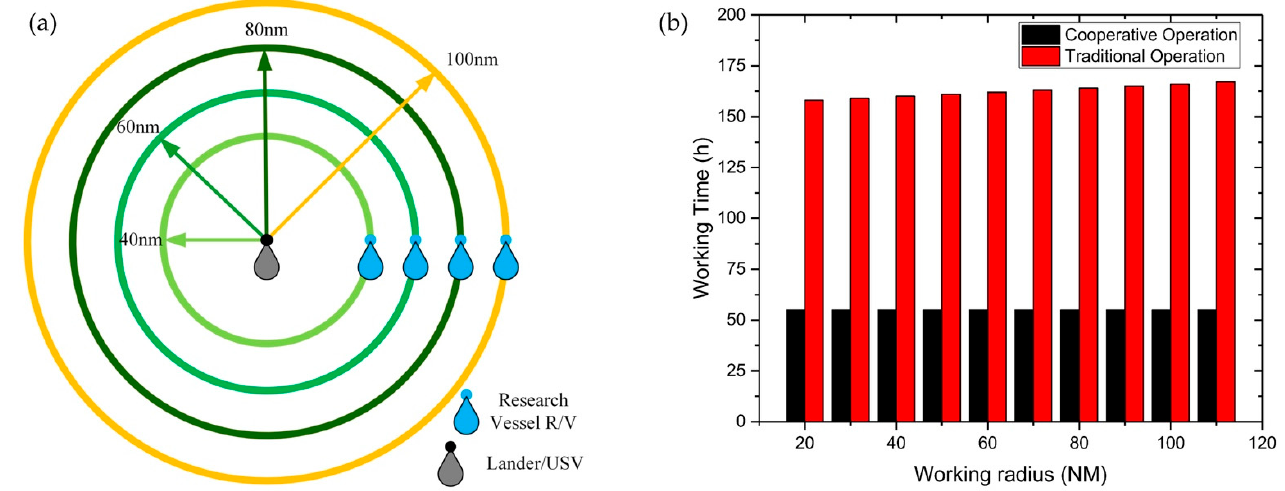
Figure 16. ( a ) Cooperative operating radius. ( b ) Operating time within different operating radii.